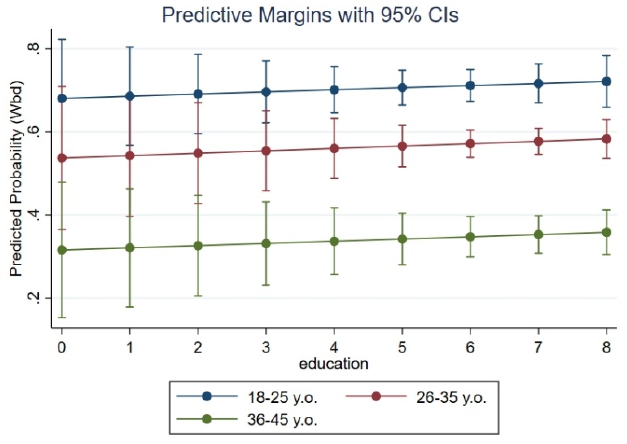
Figure 2. Predicted probabilities of the inclination towards home ownership.